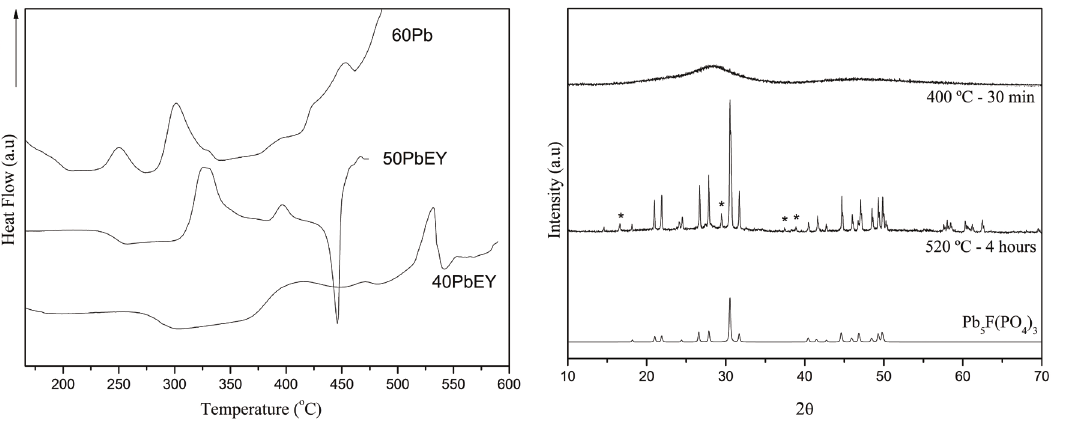
Figure 2. DSC curves of the glass samples 40PbEY, 50PbEY and 60PbEY.